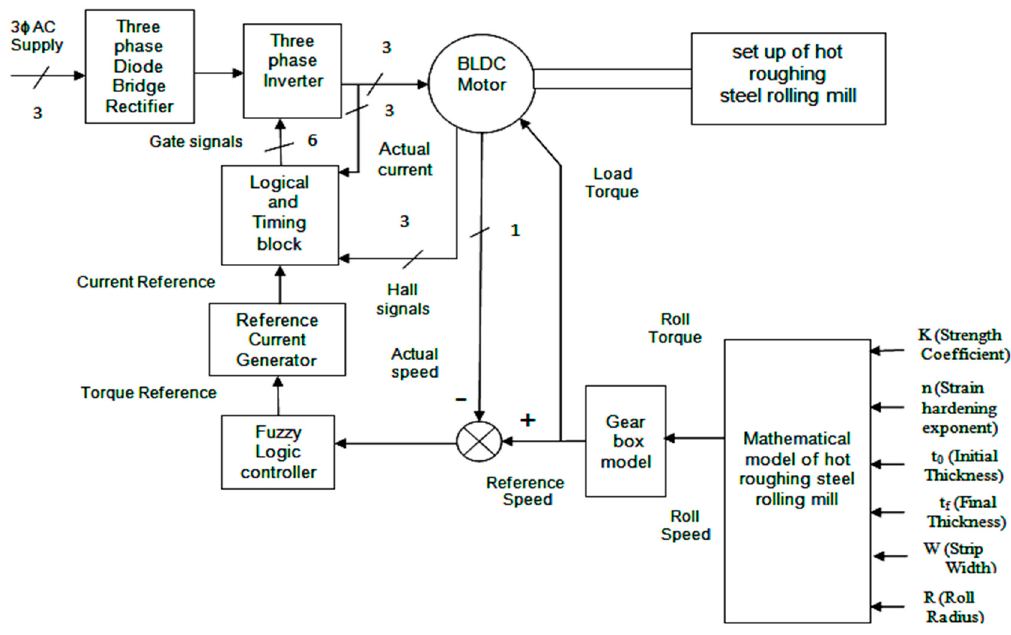
Figure 2. Schematic of steel rolling mill model and BLDC motor drive system.